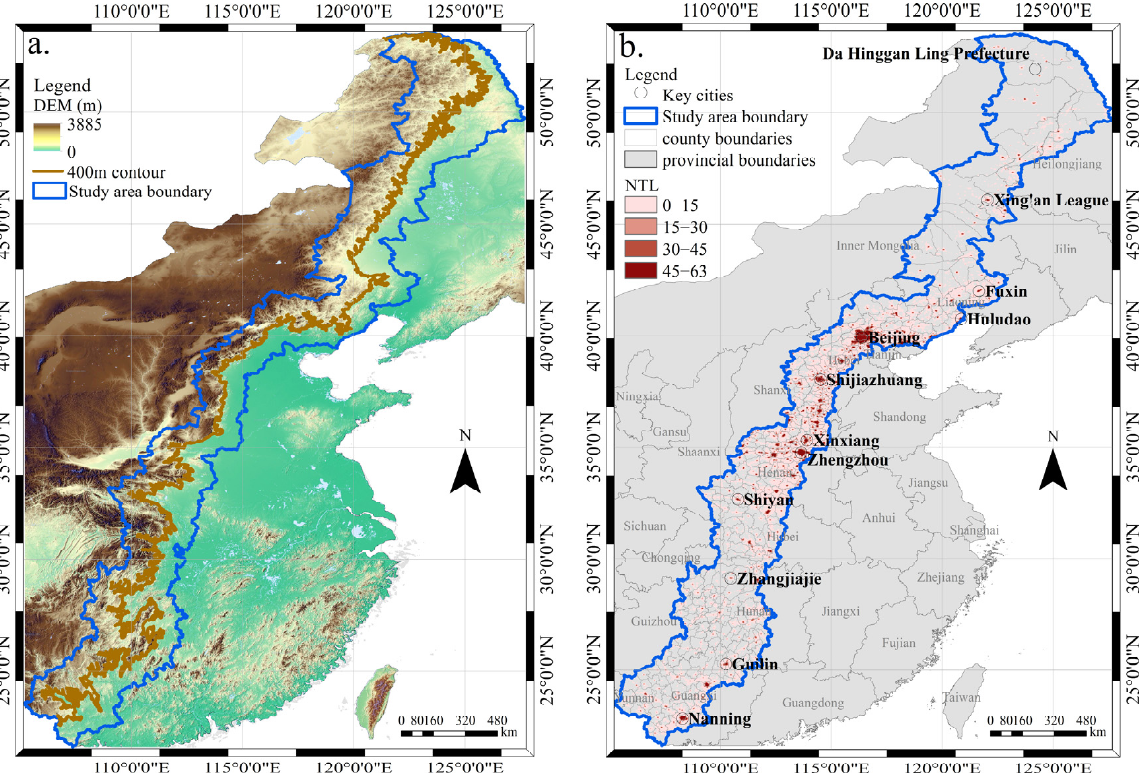
Figure 1. Overview of China’s “plain–mountain transition zone”: ( a ) Topographic map; ( b ) distribution map of nighttime light in 2020.